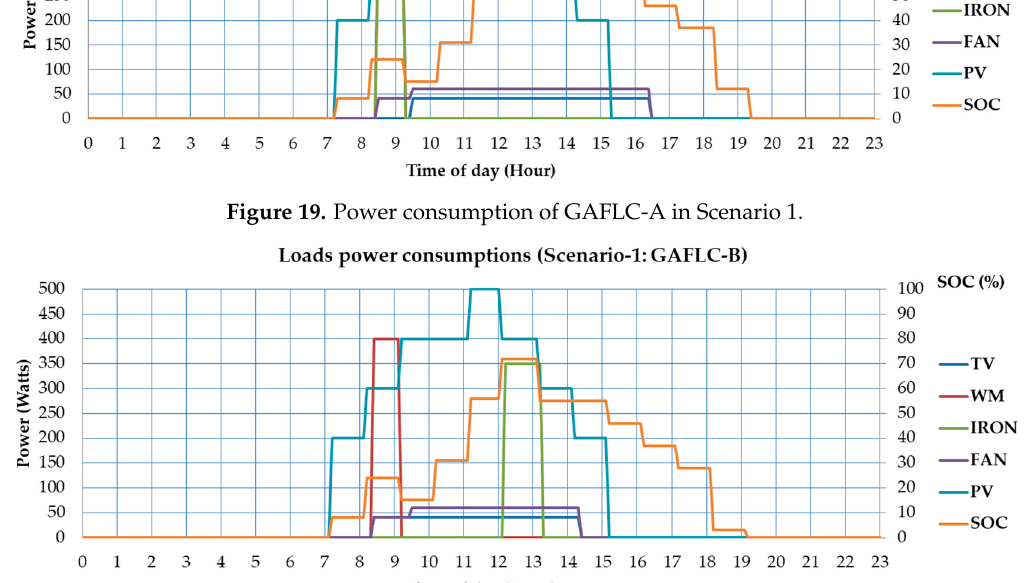
Figure 20. Power consumption of GAFLC-B in Scenario 1.